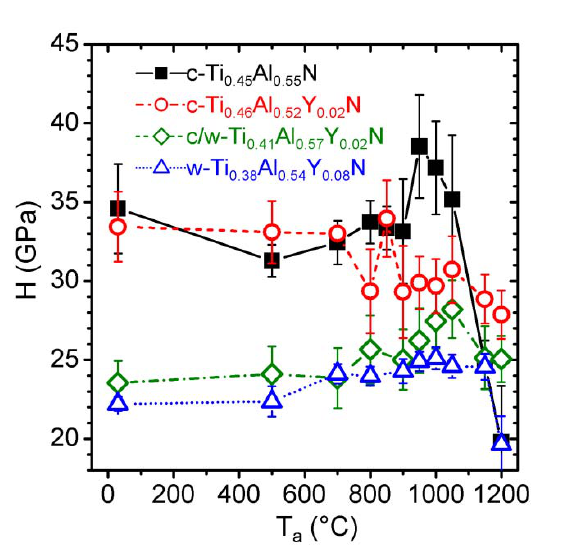
Figure 12. Hardness evolution with post-deposition annealing in He atmosphere up to Al N (0 mol % YN), c-Ti 1200 °C of c-Ti 0.45 0.55 c/w-Ti Al Y N (2 mol % YN), and single-phase w-Ti 0.41 0.57 0.02